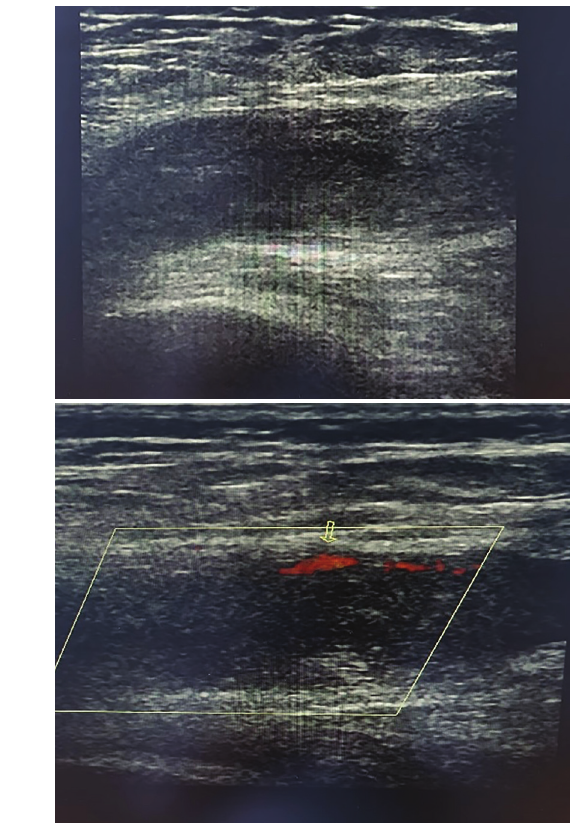
Figure 3 - Occlusive and non-occlusive thrombosis of the femoral vein